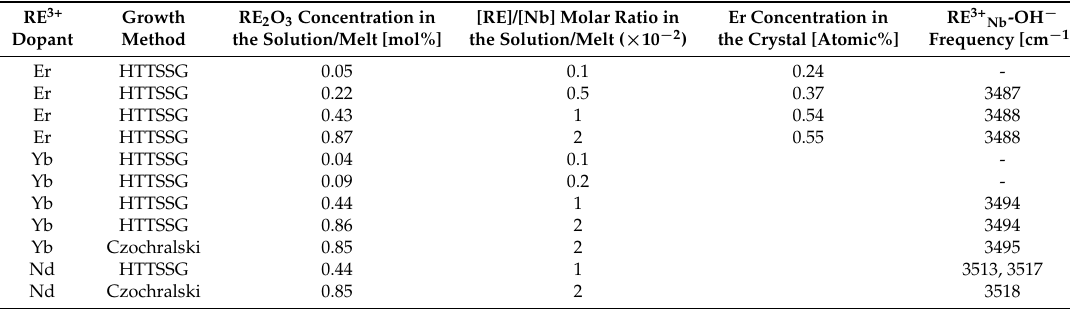
Table 1. Concentrations of rare-earth oxides in the solution or in the melt (all dopants) and in the crystal (given only for Er in atomic% relative to the number of LiNbO 3